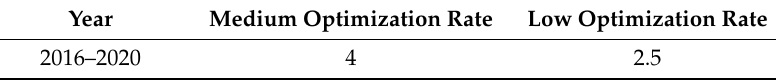
Table 7. Technical progress rates of Beijing form 2016 to 2020